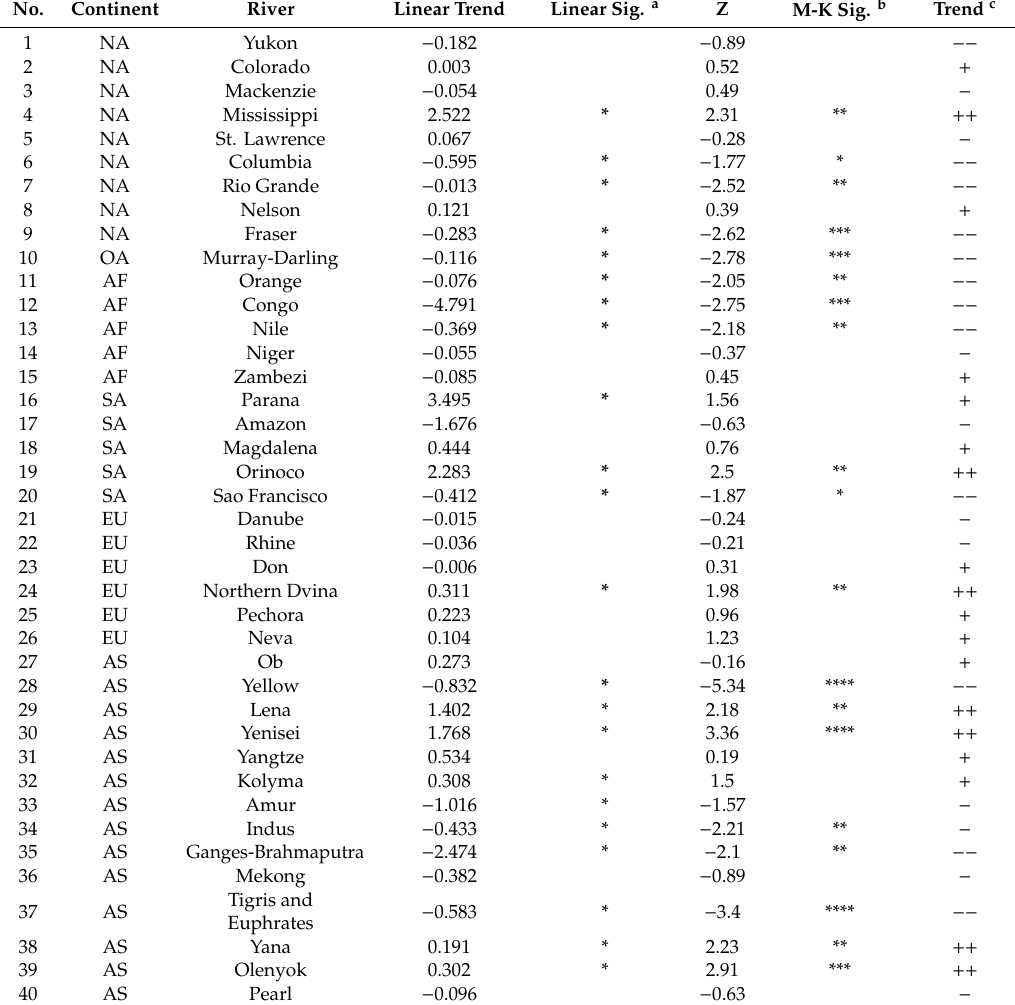
Figure 2. River discharge trends. Table 2. Results of the linear tendency estimation and M-K